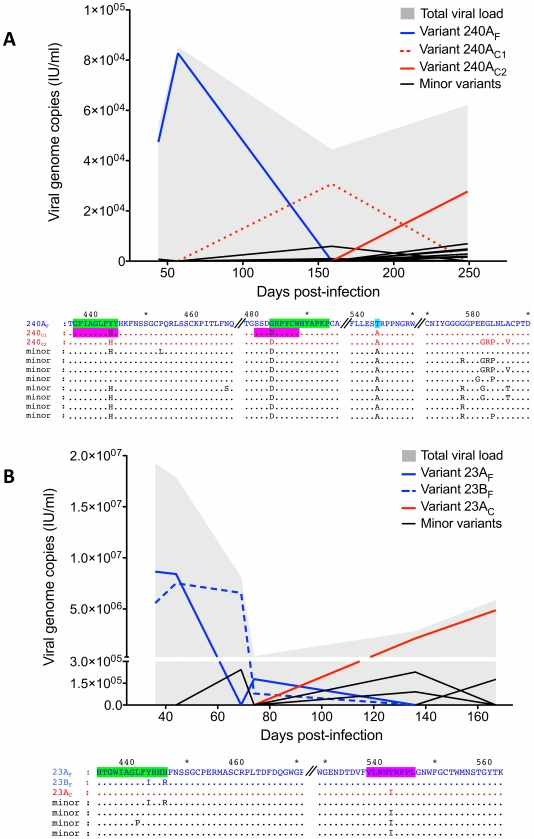
Evolution of the partial E2 region of individual HCV variants at the amino acid level.The plots in A (subject 240_Ch) and B (23_Ch) show the dynamics of the individual viral variants over time. In 240_Ch, infection was initiated with one founder variant, 240AF, which was then replaced sequentially by two related variants, 240AC1 and 240AC2, respectively. In 23_Ch, at least two founders initiated infection, 23AF and 23BF, which both dominated the early phase of infection before being replaced by a new variant in the pre-chronic phase of infection (23AC). The y-axis shows the contribution of each variant with respect to the RNA level. Below each graph is an amino acid alignment indicating the distinguishing residues for the different variants. The location of putative CTL (pink shading) and B cell (green shading) epitopes, and mutations with previously recorded viral fitness costs (light blue shading) are indicated. All the identified epitopes within this region carried at least one amino acid change. Two of these mutations (G483D for 240_Ch and T542I for 23_Ch) generated CTL epitopes with reduced binding CTL affinity, and both subjects showed a substitution at position Y443, known to be within a B cell epitope [47] - all of which is suggestive of immune escape. In addition, in 240_Ch a potential fitness cost associated mutation was observed at T543A [48].